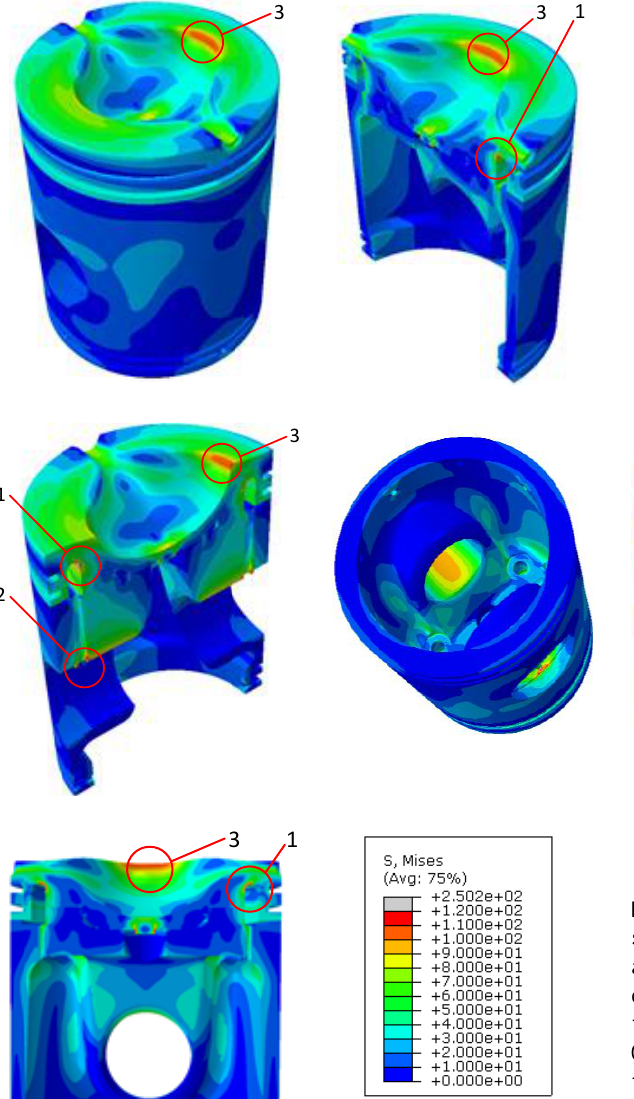
Fig. 10. Distribution of stresses on the surface of the piston